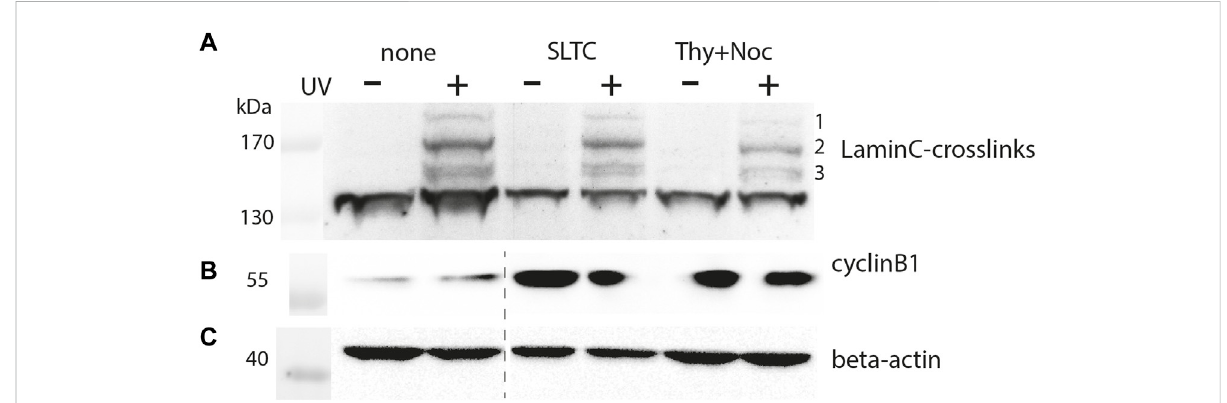
FIGURE 4 Crosslink pattern of cells synchronized in M-phase. Cells were transiently co-transfected with pLmnC-T534-3xFlag and the amber suppressor plasmid, synchronized in early M-phase as indicated and analyzed by SDS-PAGE and Western blot. Samples marked as “ none ” are derived from asynchronised cells, “ SLTC ” are samples from SLTC-inhibited cells and “ Thy+Noc ” marks samples from cells blocked fi rst in S-phase and then released into nocodazole block. Western blot detection with (A) anti-Flag, (B) anti-cyclinB1 (to probe the cell cycle stage) and (C) anti- β -actin antibodies. The dashed line in panel (B,C) indicates the position of an irrelevant lane that has been cut